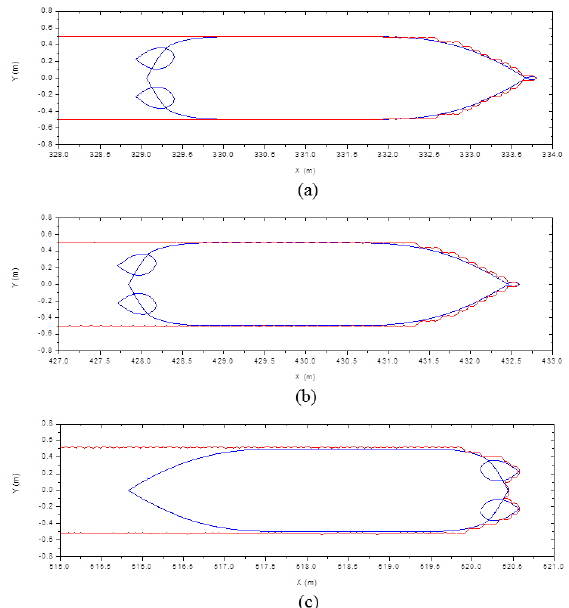
Figure 13: Examples of the simulated icebreaking runs with deterministic crack size. (a) Running ahead in 10 . 36 mm (0 . 25 m full-scale) level ice, featuring consistent shoulder crushing. (b) Running ahead in 12 . 43 mm (0 . 30 m full- scale) level ice. (c) Running astern in 12 . 43 mm (0 . 30 m full-scale) level